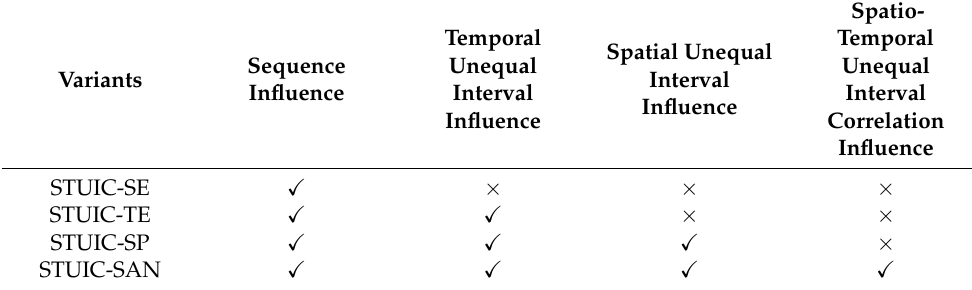
Table 7. Comparison of the variant models of STUIC-SAN.